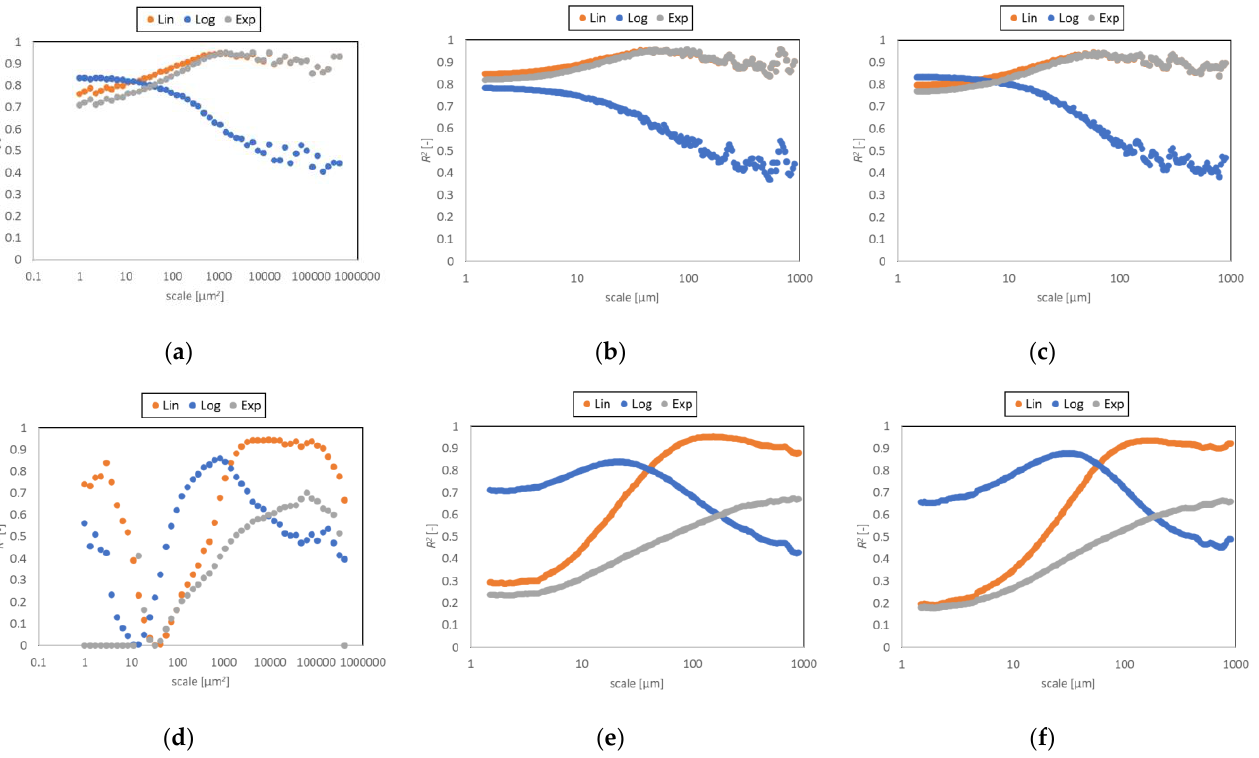
Figure 7. Coefficient of determination for linear, logarithmic, and exponential regression of area- and length-scale characterization parameters versus discharge energy plotted as a function of scale: ( a ) relative area, ( b ) relative length (rows), ( c ) relative length (columns), ( d ) area-scale fractal complexity, ( e ) length-scale fractal complexity (rows), and ( f ) length-scale fractal complexity (columns).